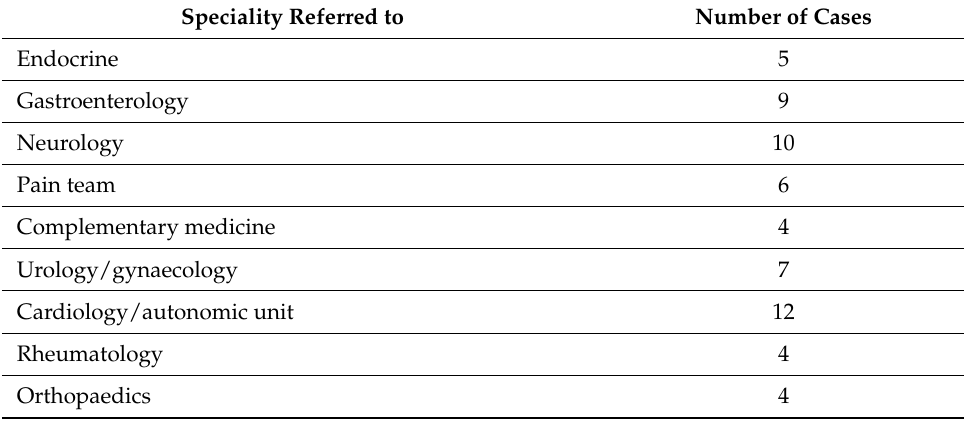
Table 4. Specialists involved.